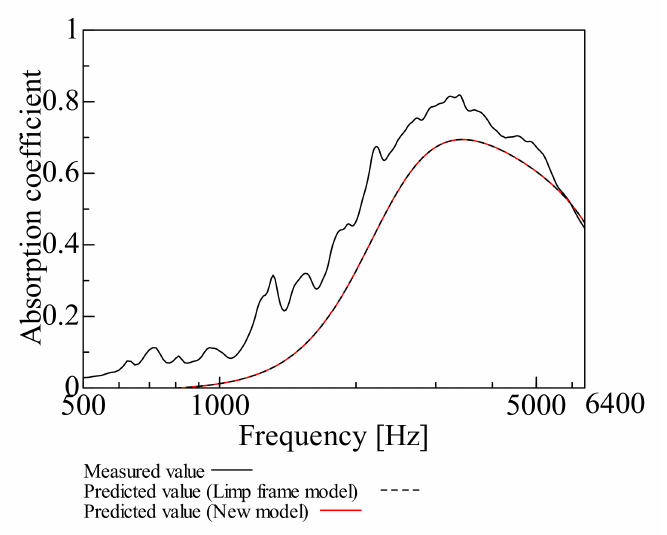
Figure 10. Comparison between the experiment and prediction (Sample B, m = 0.6 g/m 2 , t = 60 µ m, ρ = 310 kg/m 3